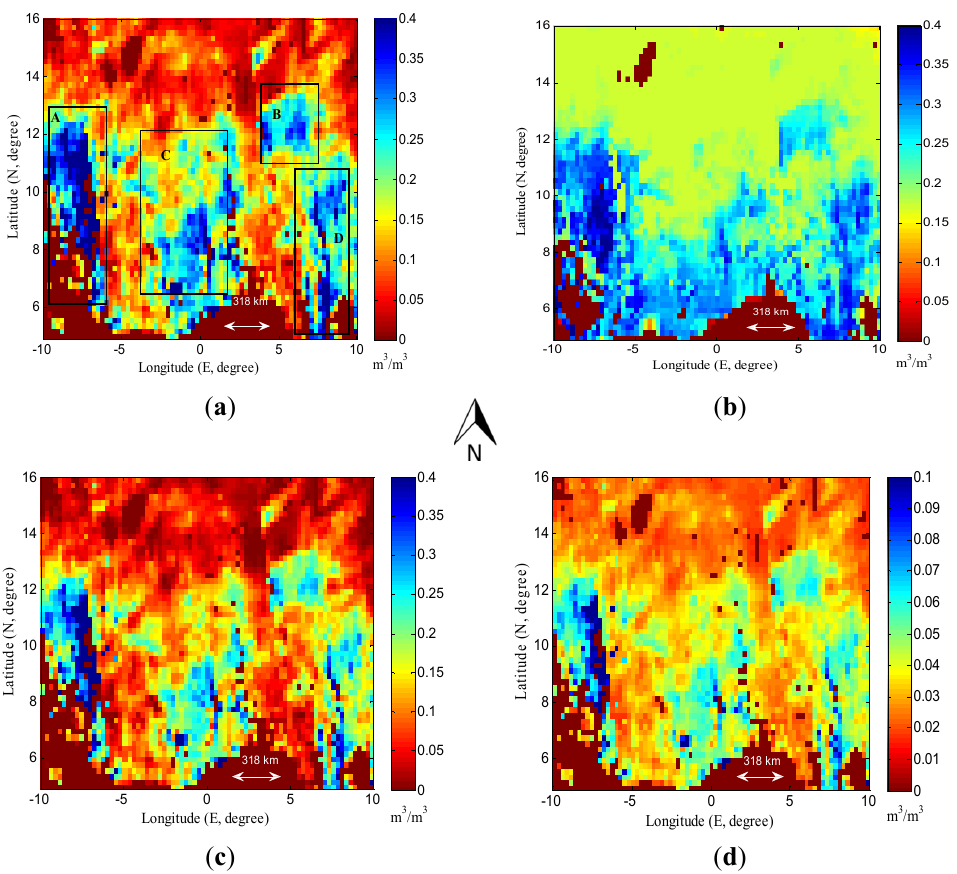
Figure 5. Spatial distribution of surface soil moisture, m 3 /m 3 : ( a ) SMOS (control run); ( b ) rescaled by CDF matching; ( c ) ensemble rescaling; ( d ) difference between (a) and (c).